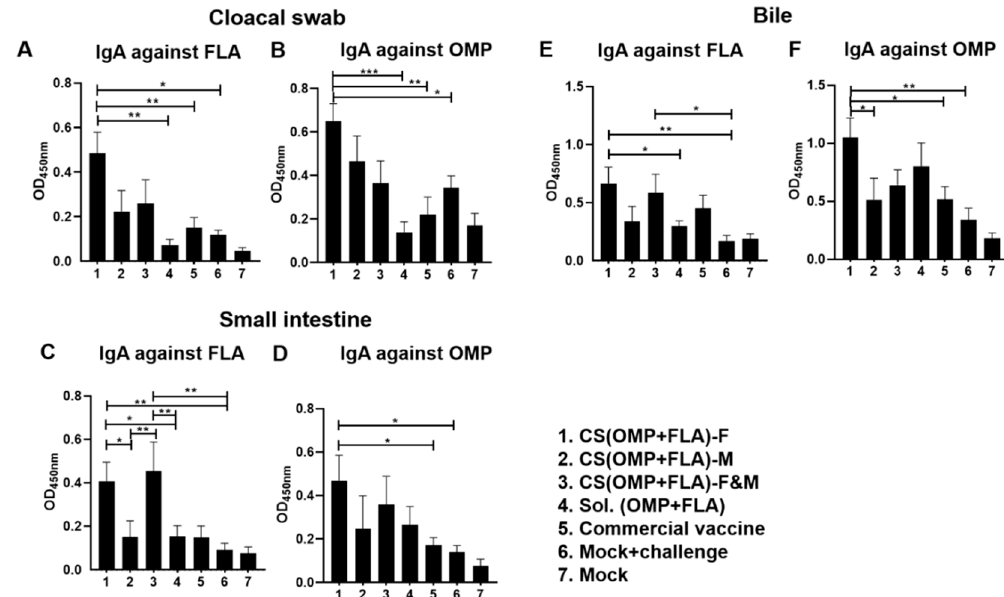
Figure 2. Salmonella antigen-specific IgA antibody in vaccinated and infected birds. Broilers were vaccinated as described in figure legend 1, challenged at the age of 5 weeks with Salmonella Enteritidis, and euthanized 10 days post-challenge, and samples were collected for specific IgA antibody analysis by ELISA. The anti-FLA IgA antibody response in ( A ) cloacal swab, ( C ) small intestine wash, and ( E ) bile samples. The anti-OMP IgA antibody response in ( B ) cloacal swab, ( D ) small intestine wash, and ( F ) bile samples. Data are presented as the mean ± SEM of 6 to 13 birds per group. Significant differences were determined by one-way ANOVA followed by Tukey post-hoc test between each of the groups. Only significant differences are labelled in the figures (* p < 0.05, ** p < 0.01, and *** p < 0.001).